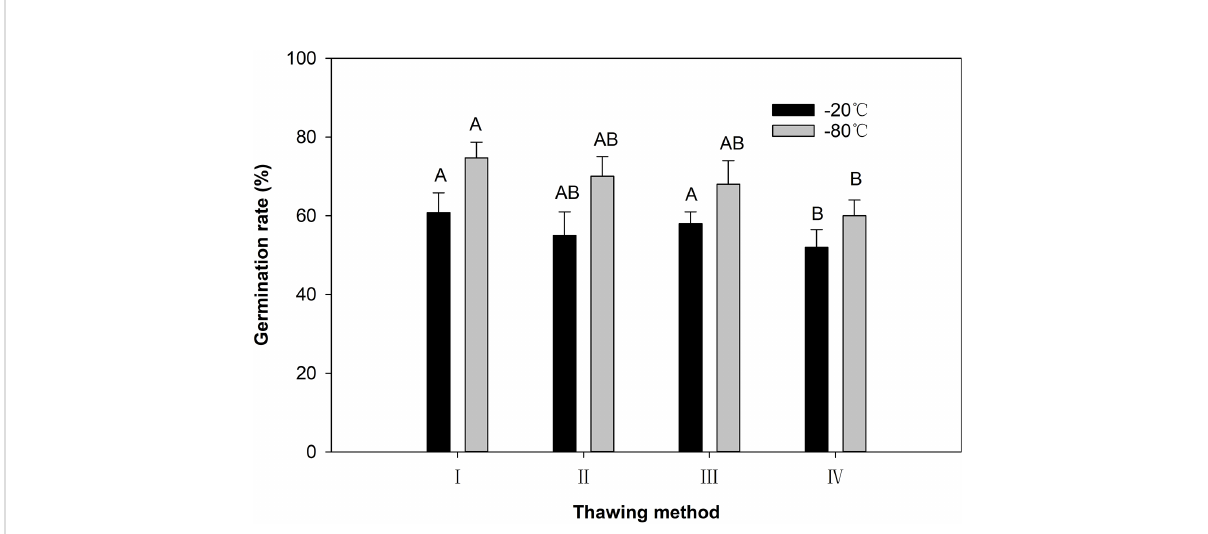
FIGURE 5 The pollen germination rate after different thawing ways. I: Thawing in a water bath at 35°C for 4 min; II: Thawing in a refrigerator at 4°C for 30 min; III: Thawing with running tap water at 18°C for 30 min; IV: Thawing at room temperature (25°C) for 30 min. Different capital letters indicate very signi fi cant difference ( P <